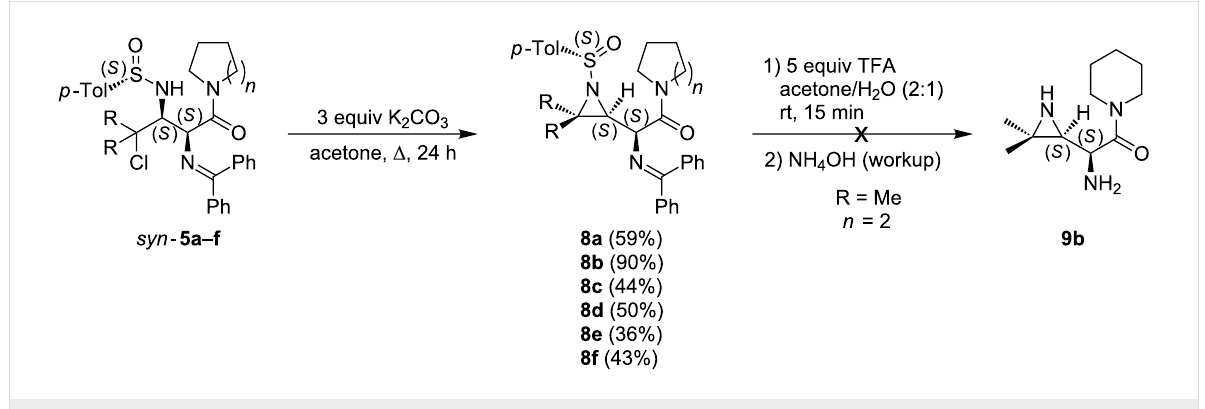
Scheme 4: Synthesis of N -sulfinyl- β , γ -aziridino- α -amino carboxylic amides 8